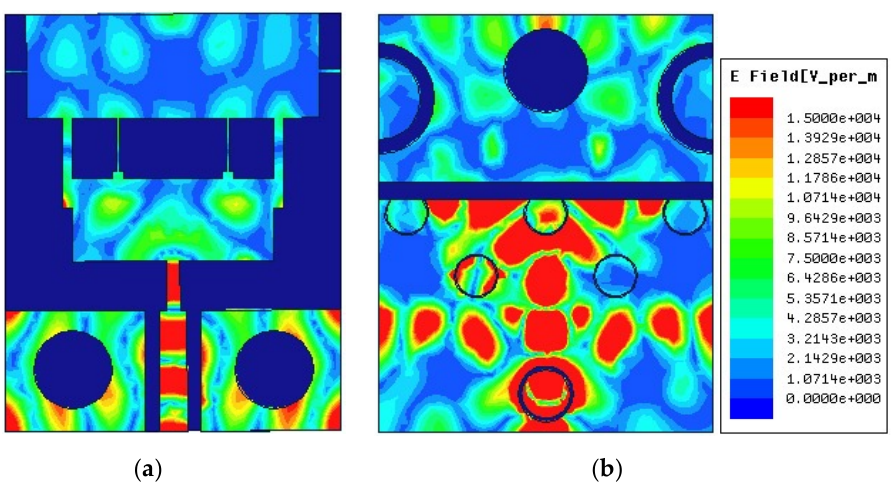
Figure 13. The surface current distribution of the proposed mmWave antenna ( a ) Top view; ( b ) Bottom view.